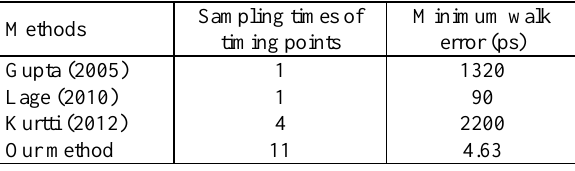
Table 2. The comparison of experimental accuracy for other timing discrimination with